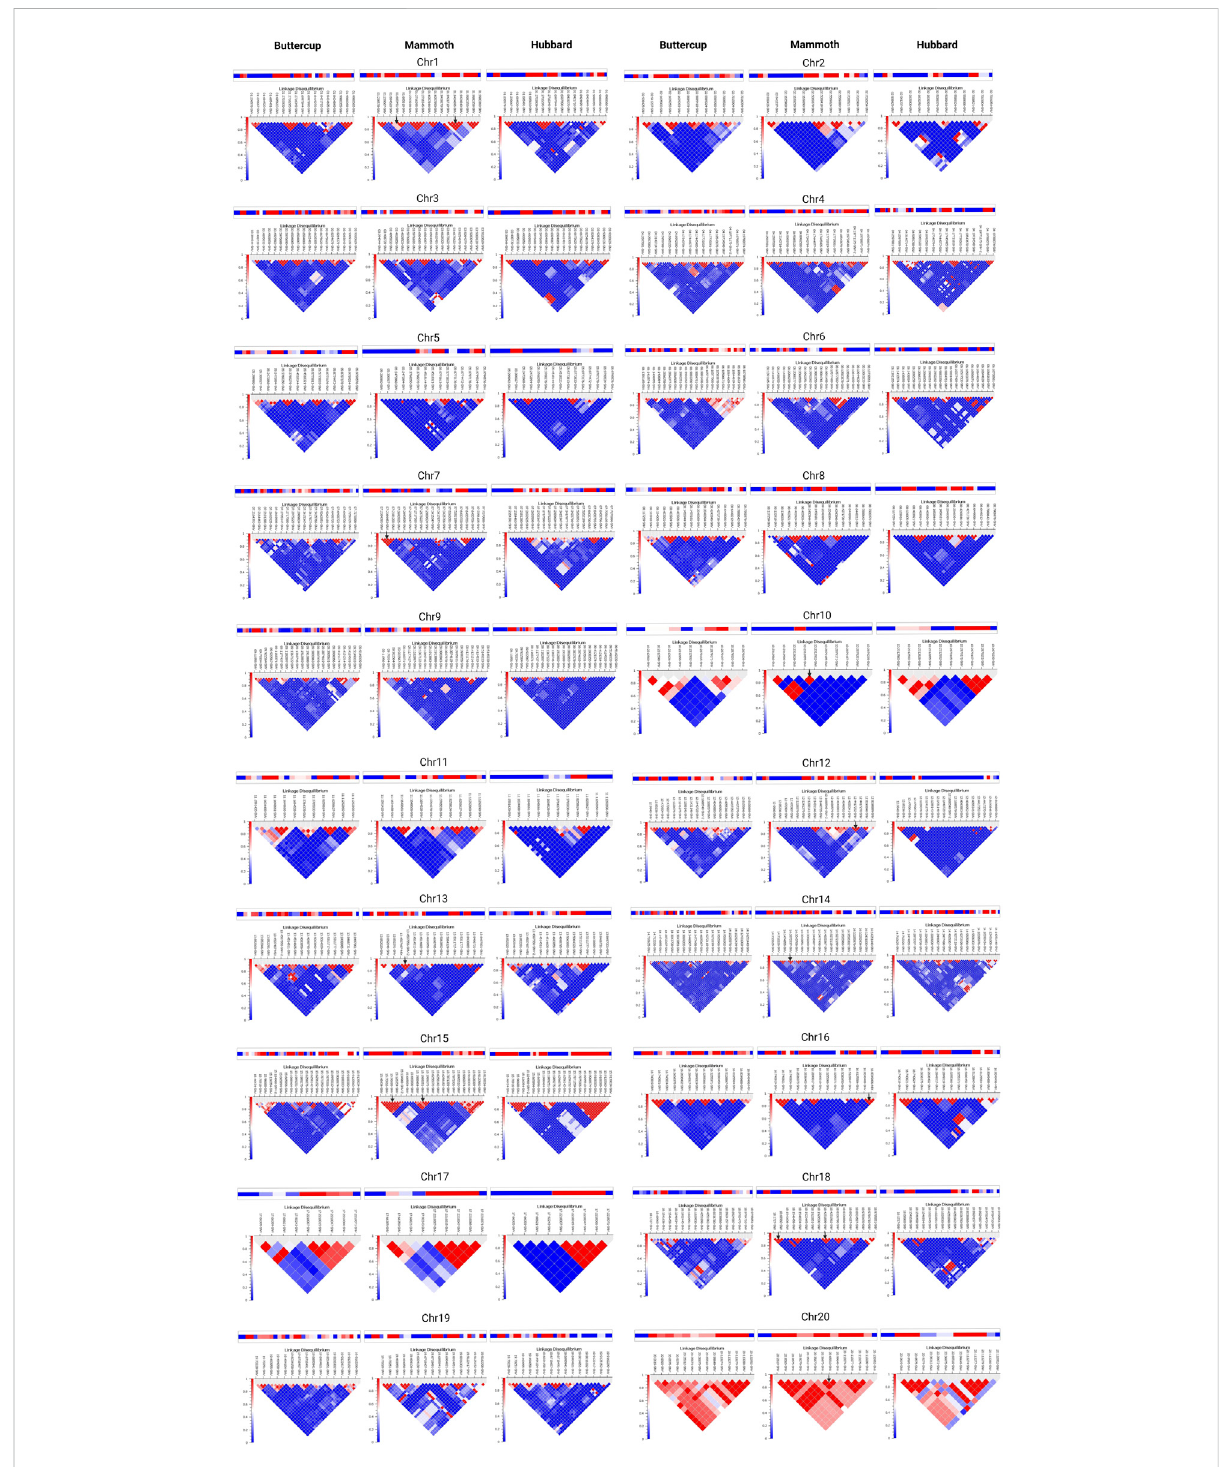
FIGURE 4 Distribution of haplotypes shared across buttercup, mammoth, and hubbard groups for chromosomes 1 to